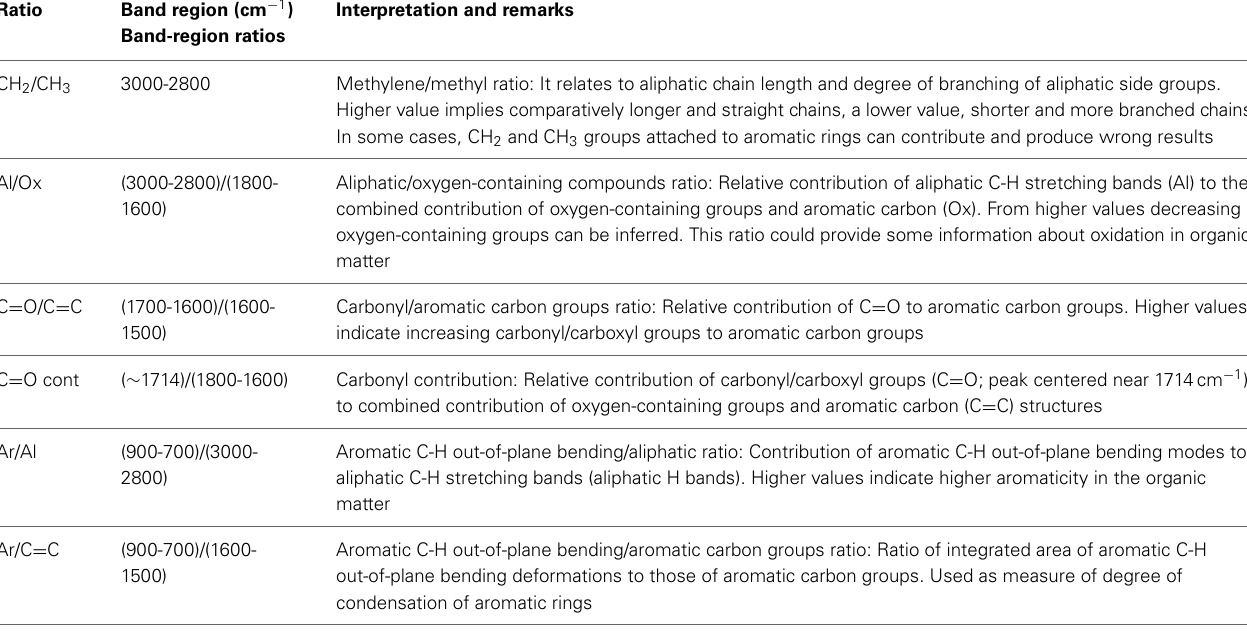
Table 2 | Definition of semi-quantitative ratios from FTIR and their interpretation for the characterization of fossilized plant cuticles (adapted from Zodrow et al., 2012a).